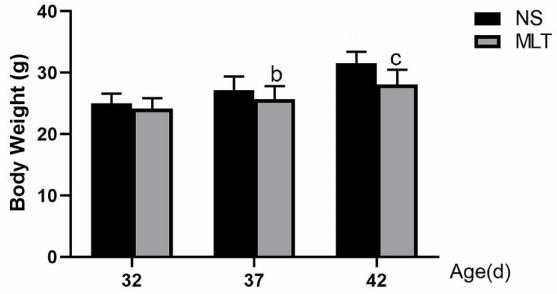
Figure 2. Melatonin’s effects on female mice’s body weight (n = 13). b: p < 0.05 vs. 37 dNS; c: p < 0.05 vs. 42 dNS; 32 d, 32 days; 37 d, 37 days; 42 d, 42 days; NS, normal saline; MLT,